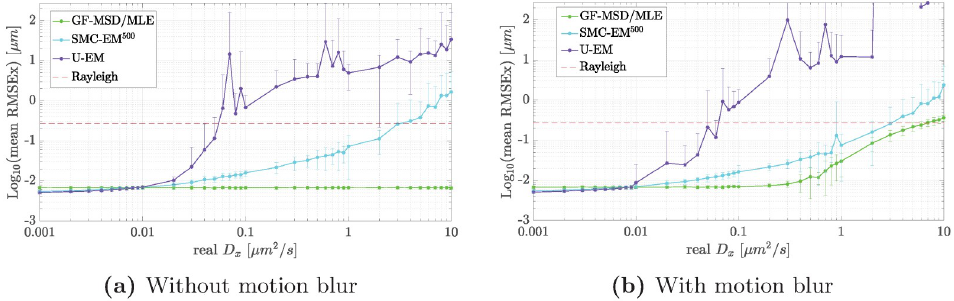
Fig 10. Localization performance in terms of RMSE across varying diffusing speeds. (a) without and (b) with motion blur using GF-MSD/MLE (green), SMC-EM 500 (cyan), and U-EM (purple). The failure threshold is defined as the Rayleigh resolution criterion (red,